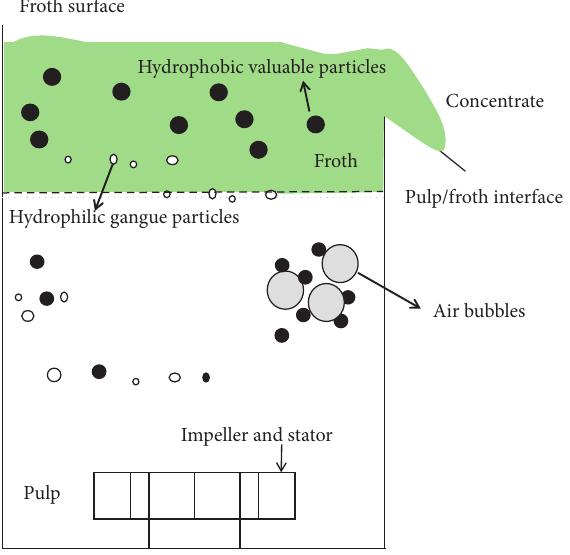
Figure 1: Processes of true flotation and entrainment in a flotation cell (after [7]).